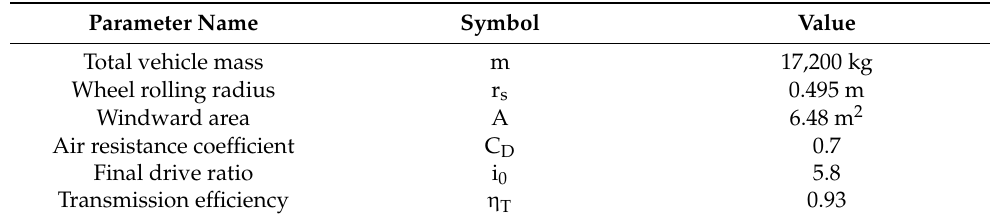
Table 7. Parameters of the HFC vehicle and its power system in the dynamic system load